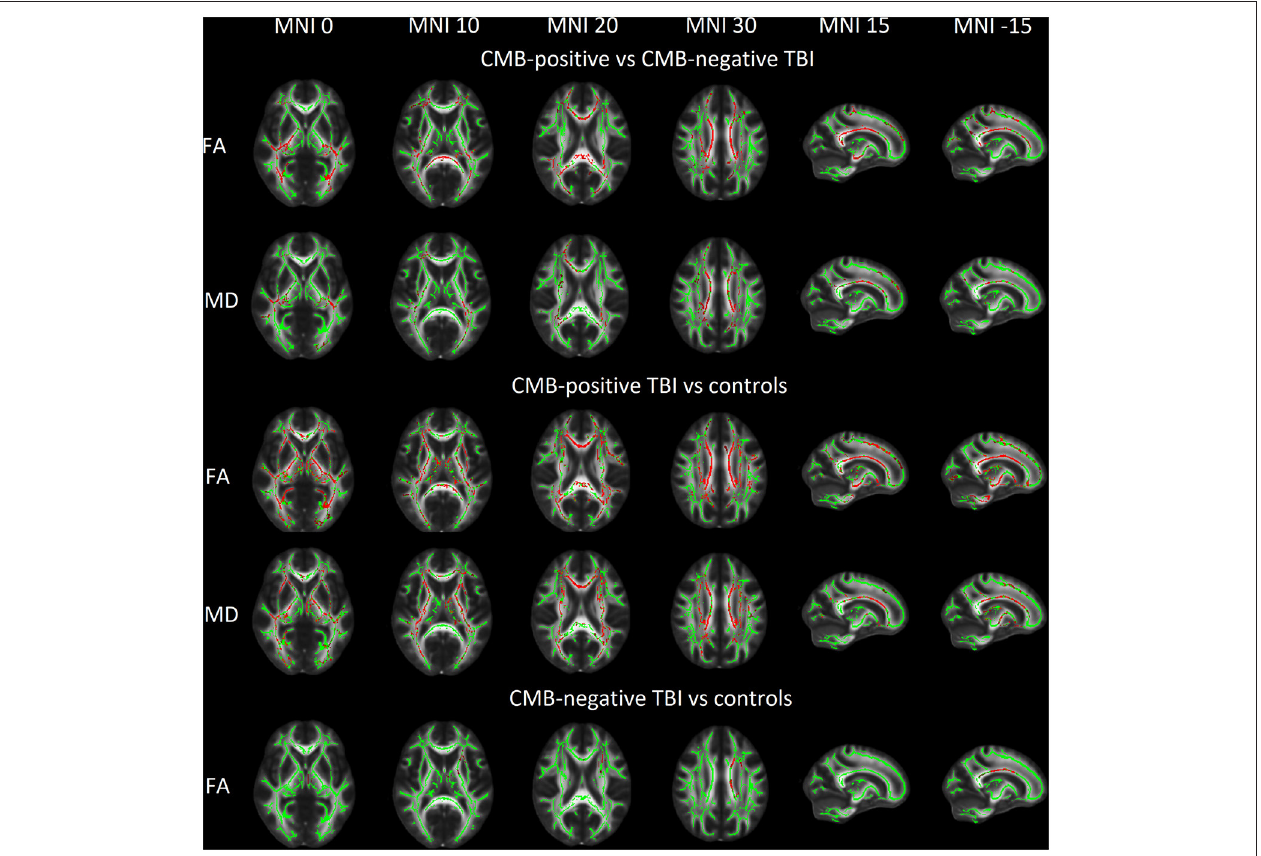
FIGURE 3 | Group comparison of fractional anisotropy (FA) and mean diffusivity (MD) with statistically significant voxels (shown in red) overlaid on mean FA skeleton (shown in green) and Oxford Center for Functional MRI of the Brain mean FA template in Montreal Neurological Institute (MNI) 152 space. CMB, cerebral microbleed, TBI, traumatic brain